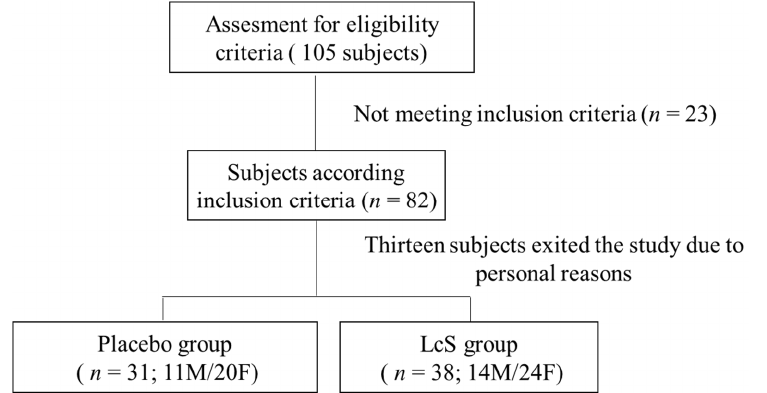
Figure 2. CONSORT study flow chart. M: male; F; female.